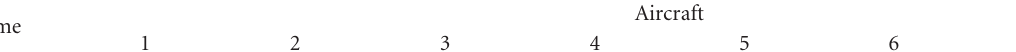
Table 3: Ideal taxi plan (with